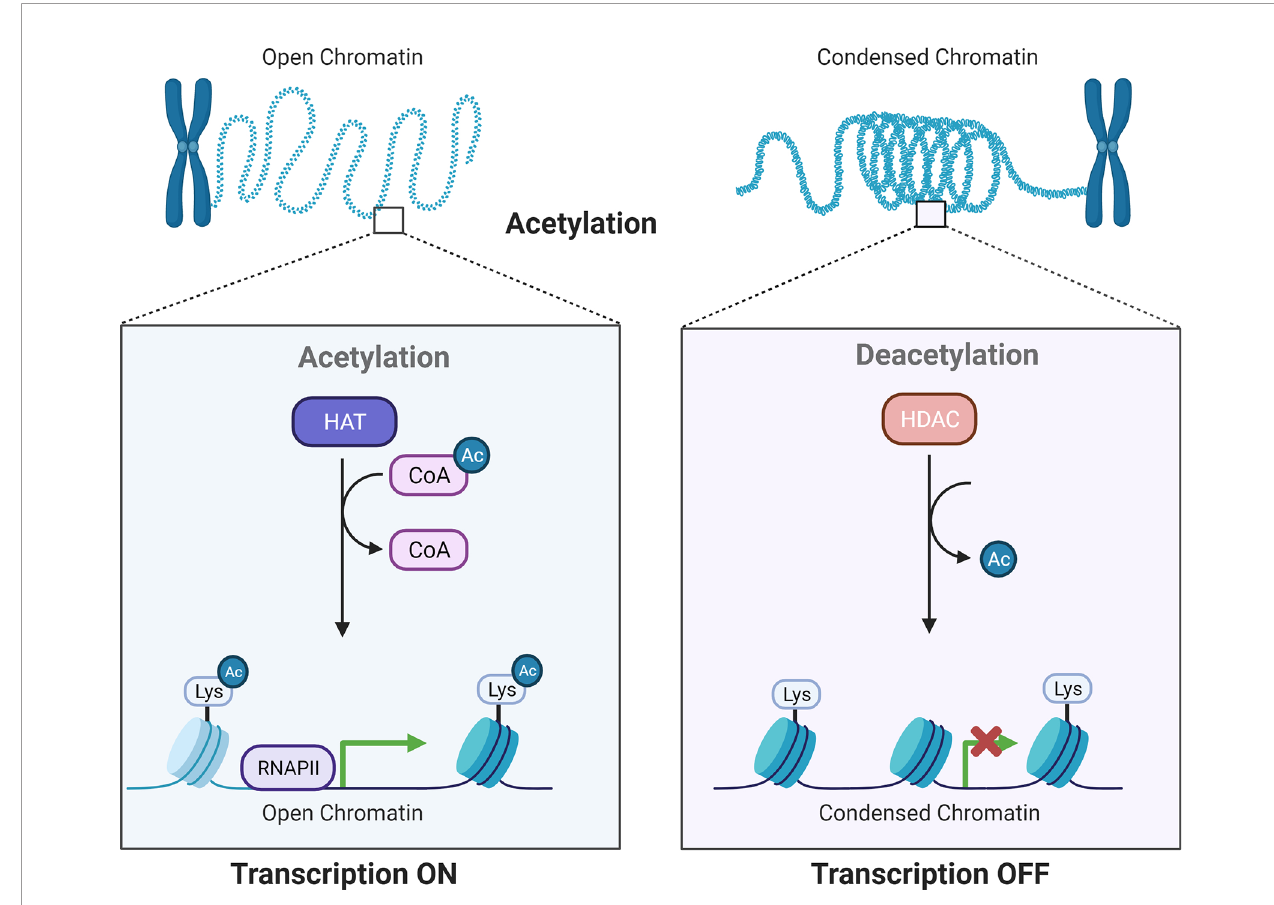
FIGURE 1 | Acetylation by HATs and deacetylation by HDACs in fl uence gene transcriptional activity. HATs and HDACs add or remove acetyl groups at the N − terminus lysine, which leads to an open or condensed state of the